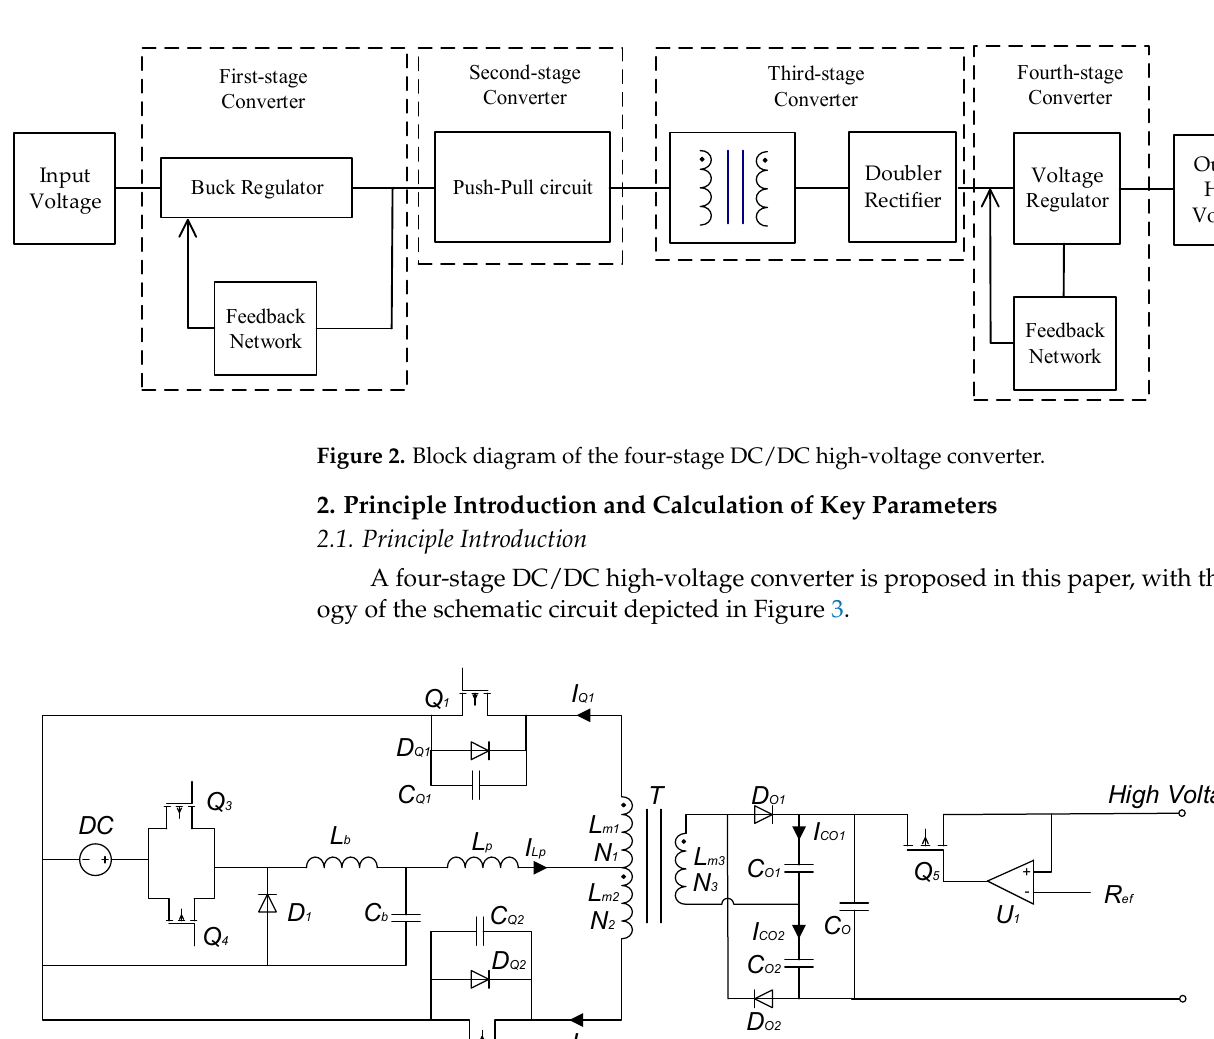
Figure 3. Topology of the four-stage DC/DC high − voltage converter.